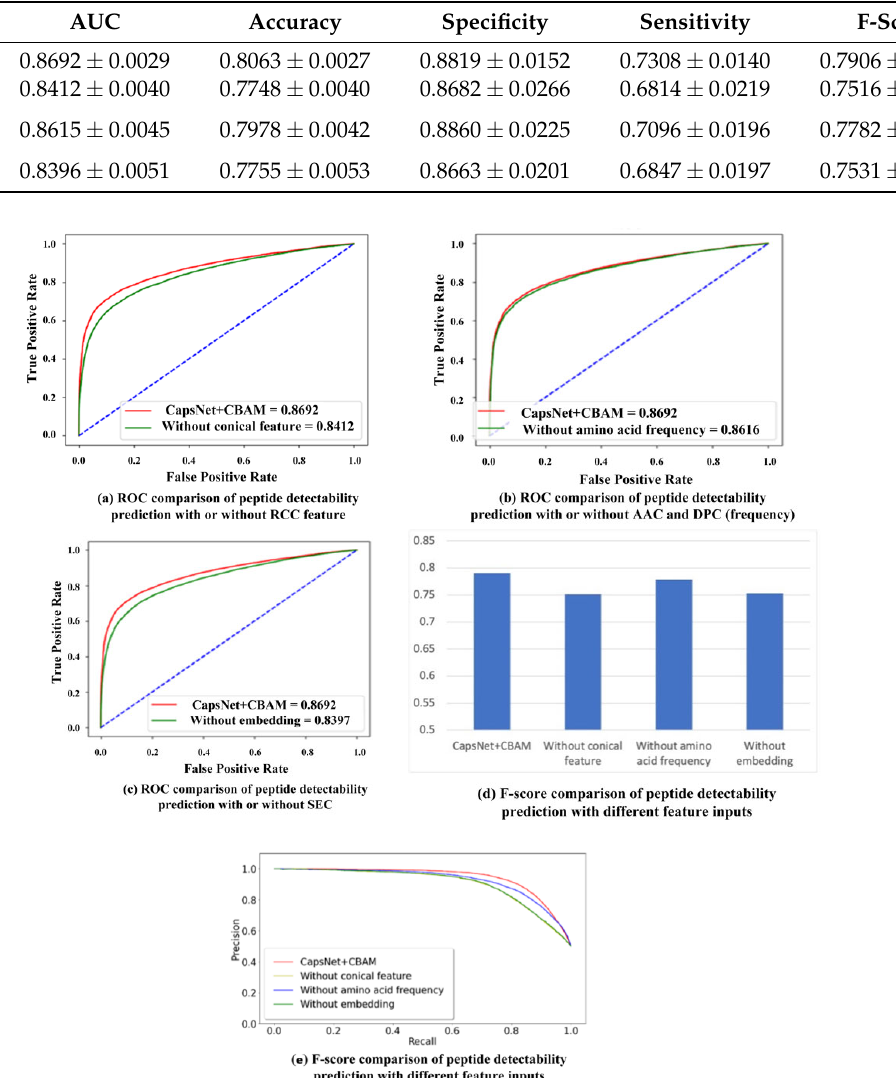
Figure 2. Performance comparison with different feature inputs for peptide detectability prediction on the test set from GPMDB.